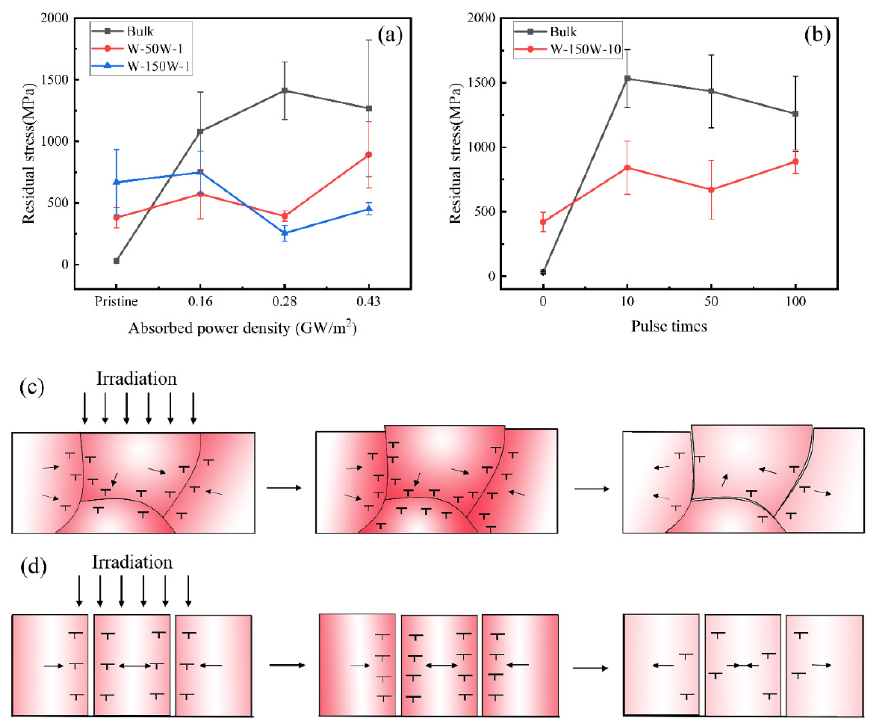
Figure 7. The residual stress of the samples irradiated using a pulsed electron beam ( a ), and HIPIB ( b ). Schematic diagram of the stress evolution of the bulk W ( c ) and the W film ( d ) under irradiation. The sign ┬ represents dislocation; the shades of red represent the stress.